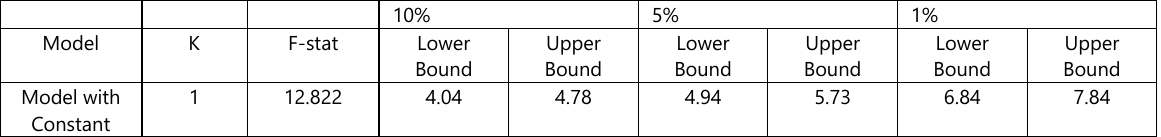
10% 5% 1% Upper Lower Upper Lower Upper Bound Bound Bound Bound Bound Bound